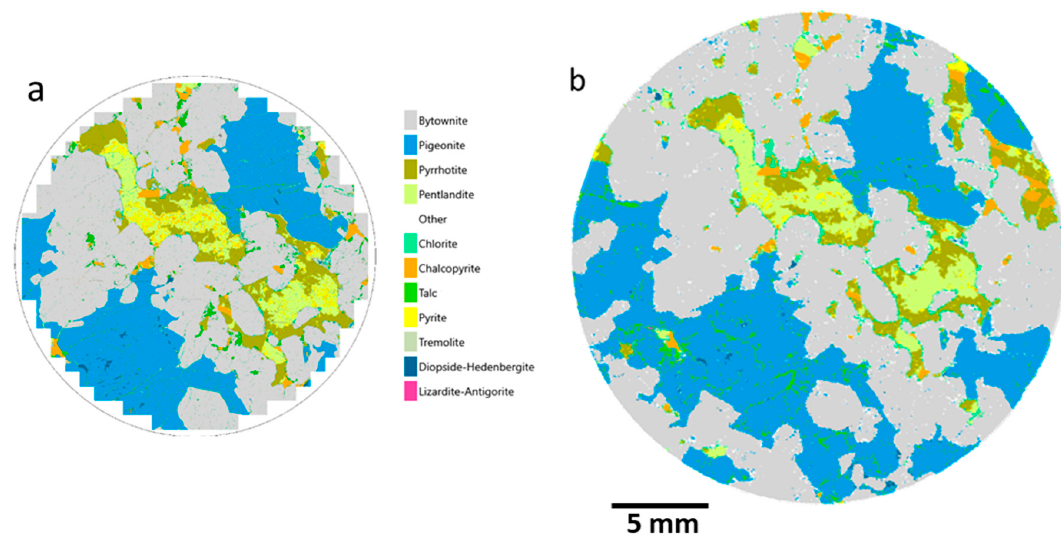
Figure 6. The mineral maps for the PGE1a sample obtained by TIMA ( a ) and LIBS CORIOSITY ( b ). Table 5. The mineral mass distribution obtained by TIMA and LIBS CORIOSITY on PGE1a. Mineral TIMA Mineral Mass